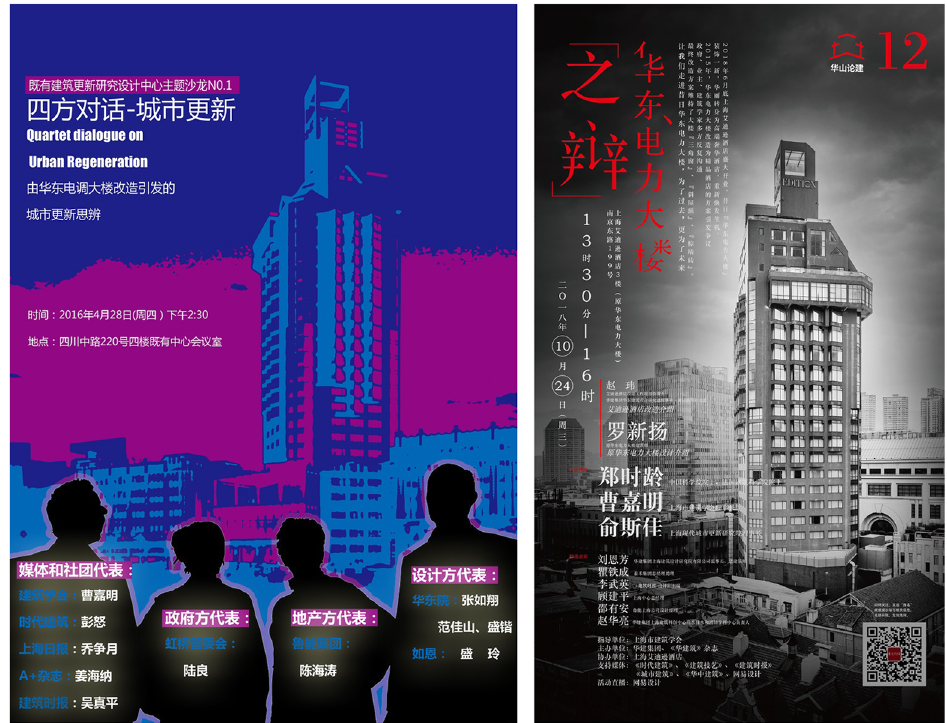
Fig. 12 Posters for Quartet Dialogue on Urban Regeneration (2016) and Debate on East China Electric Power Building (2018) (Source: